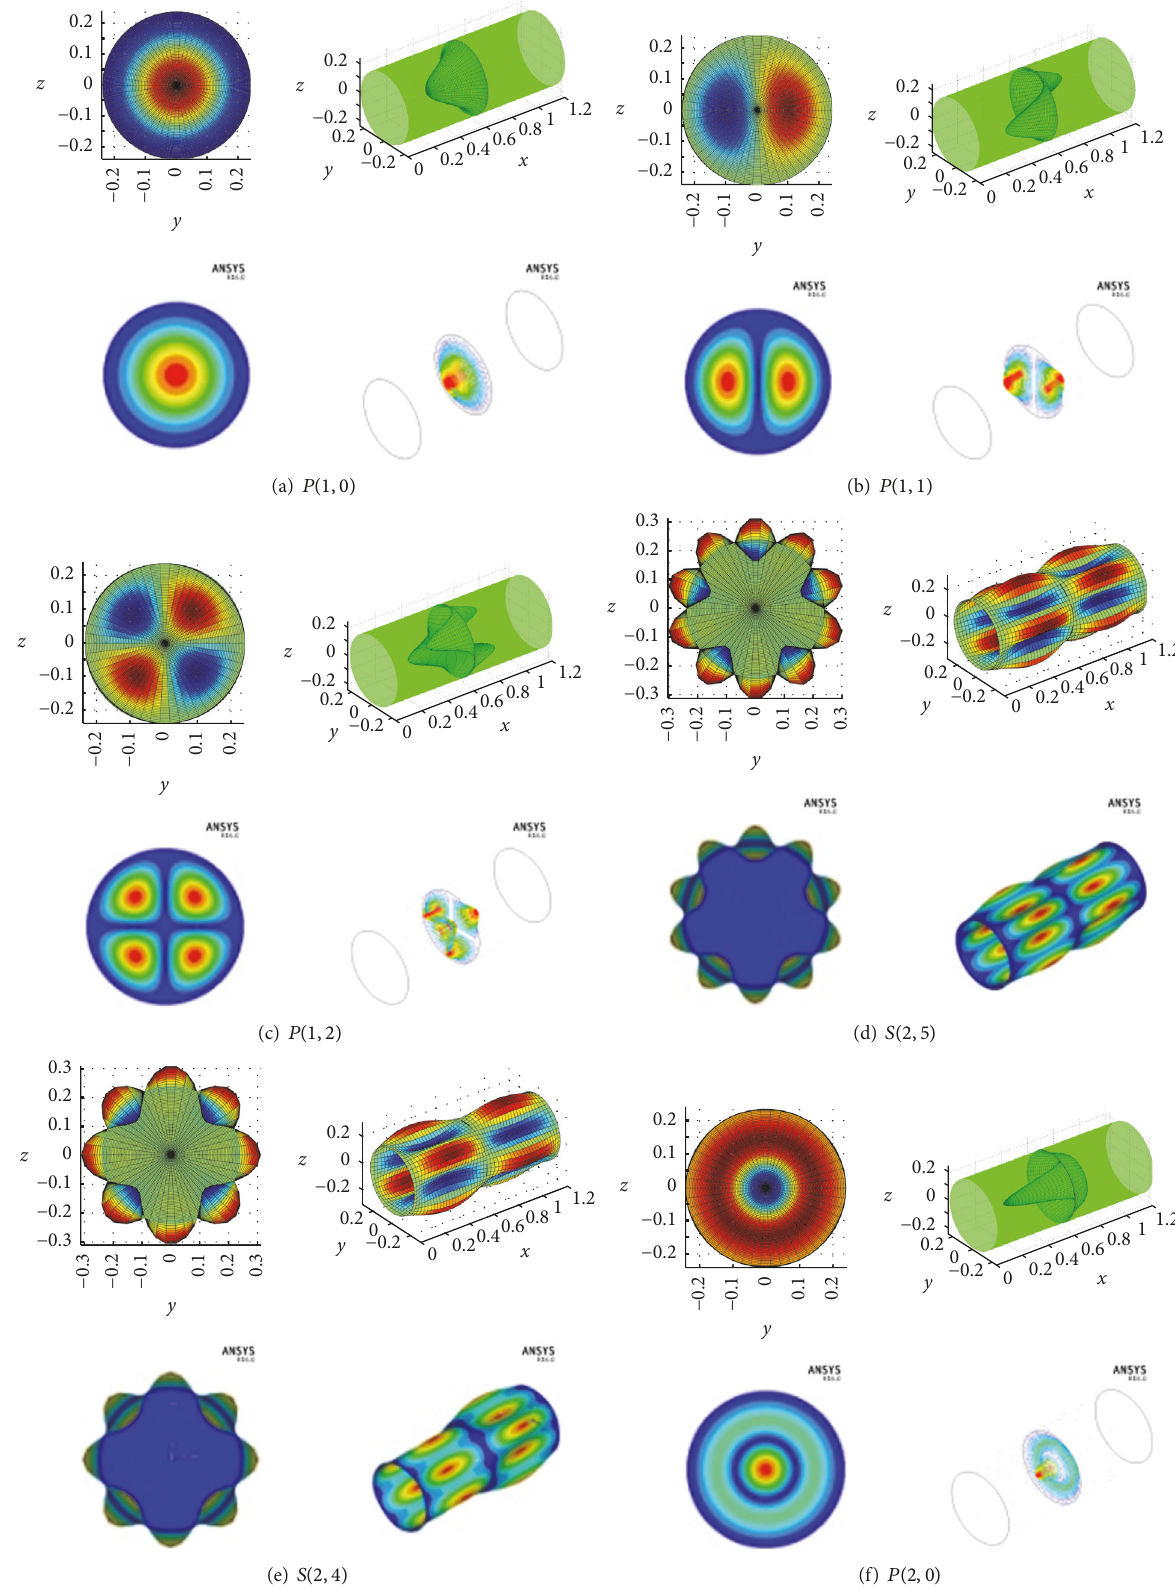
Figure 3: The modes of coupled structures with